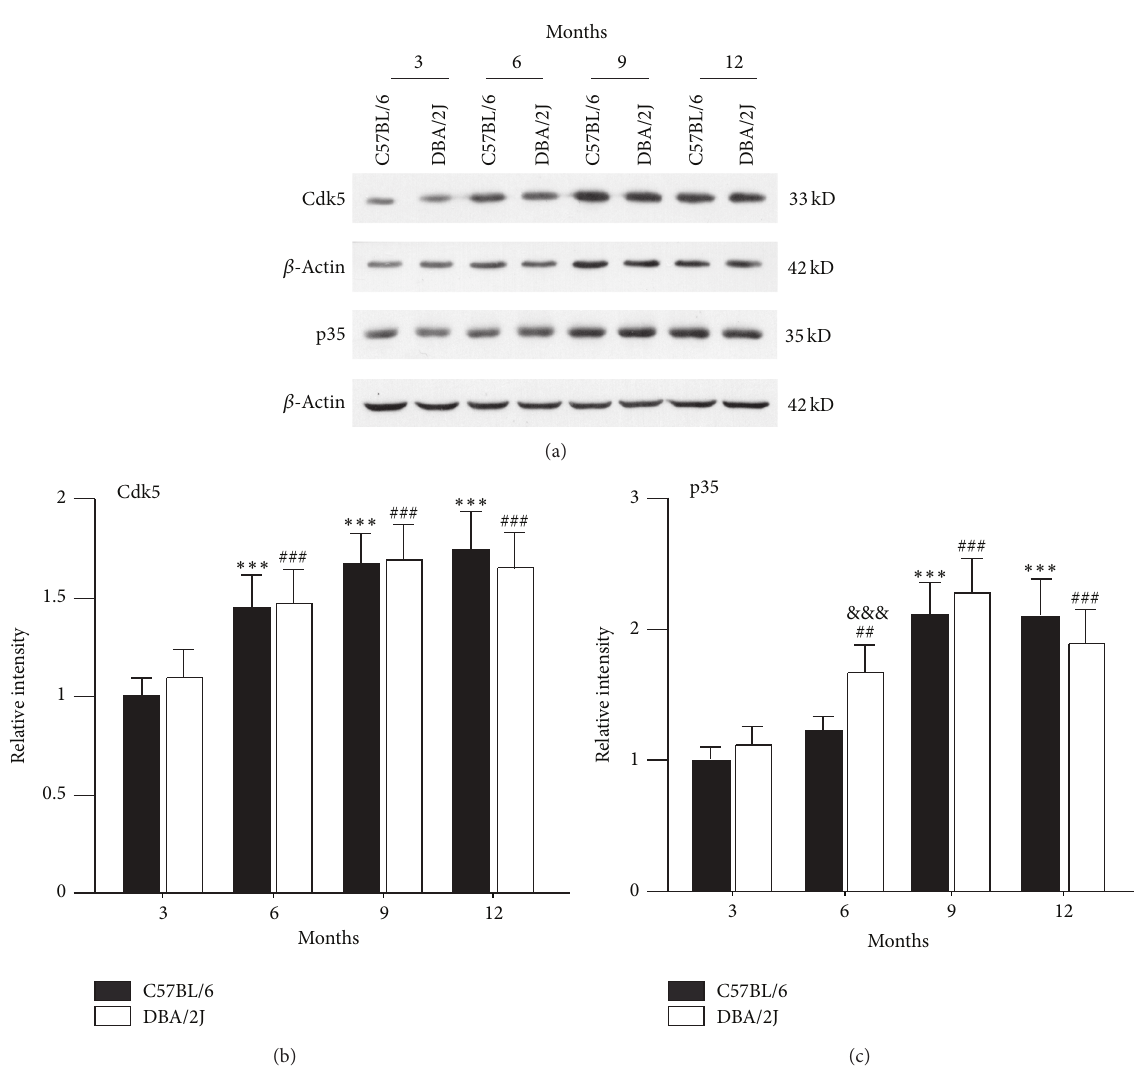
Figure3: Changes inexpressionof Cdk5, p35 of DBA/2Jmiceat various ages. (a)RepresentativeimmunoblotsshowingthechangesofCdk5and p35 levels in DBA/2J and C57BL/6 mice at ages of 3, 6, 9, and 12 months. ((b), (c)) Bar chart showing the average densitometric quantification of immunoreactive bands of Cdk5 (b) and p35 (c) in DBA/2J and C57BL/6 mice at ages of 3, 6, 9, and 12 months, respectively. ∗∗∗ 𝑃 < 0.001 versus 3-month-old C57BL/6 mice; ## 𝑃 < 0.01 and ### 𝑃 < 0.001 versus 3-month-old DBA/2J; &&& 𝑃 < 0.001 versus age-matched C57BL/6